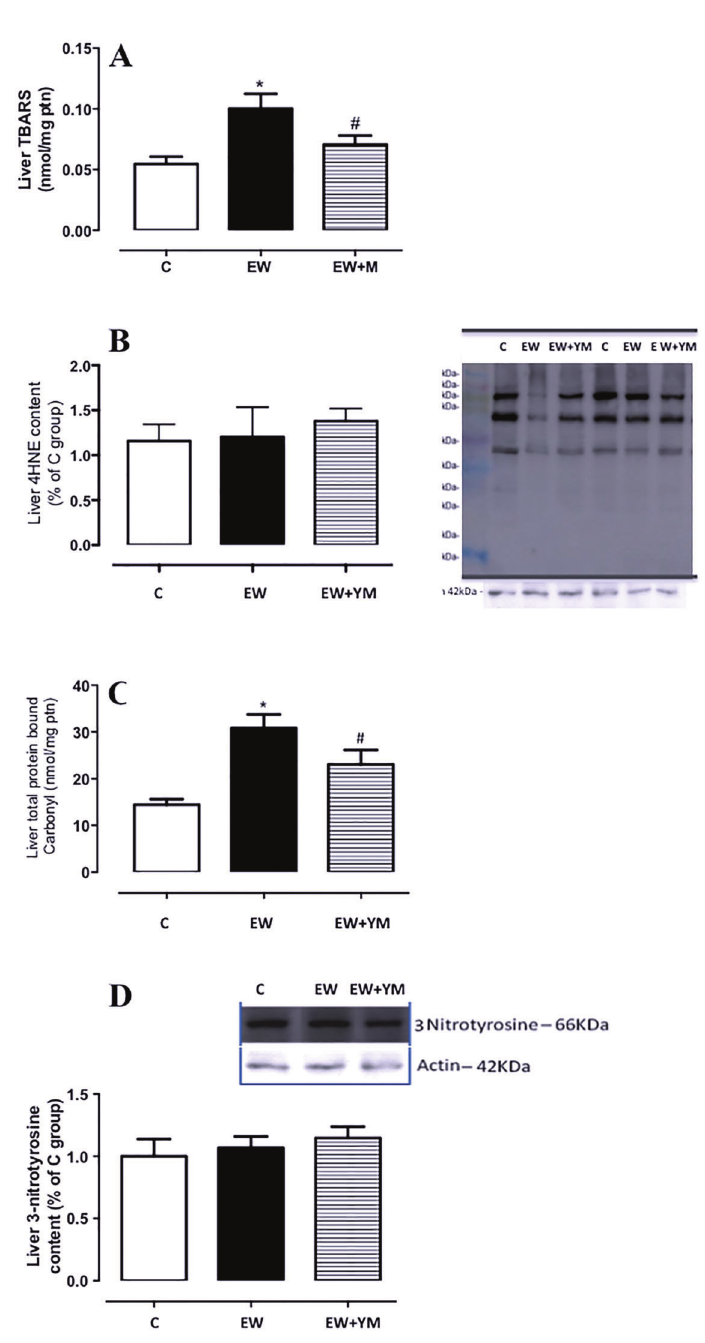
Figure 4. Yerba mate treatment prevented the increase of thiobarbituric acid reactive substances (TBARS) and total protein bound carbonyl in the liver caused by early weaning. A , TBARS content, B, 4-hydroxynonenal (4HNE) protein adducts, C , total protein bound carbonyl, and D , 3-nitrotyrosine in the liver at postnatal day 180 of adult rats that were normally breastfed for 21 days (C), early weaned (EW), or EW that received yerba mate for 30 days (EW + YM). Data are reported as means ± SE of 10 rats per group. *P o 0.05 vs C; # P o 0.05 vs EW (ANOVA and Newman-Keuls multiple com- parison